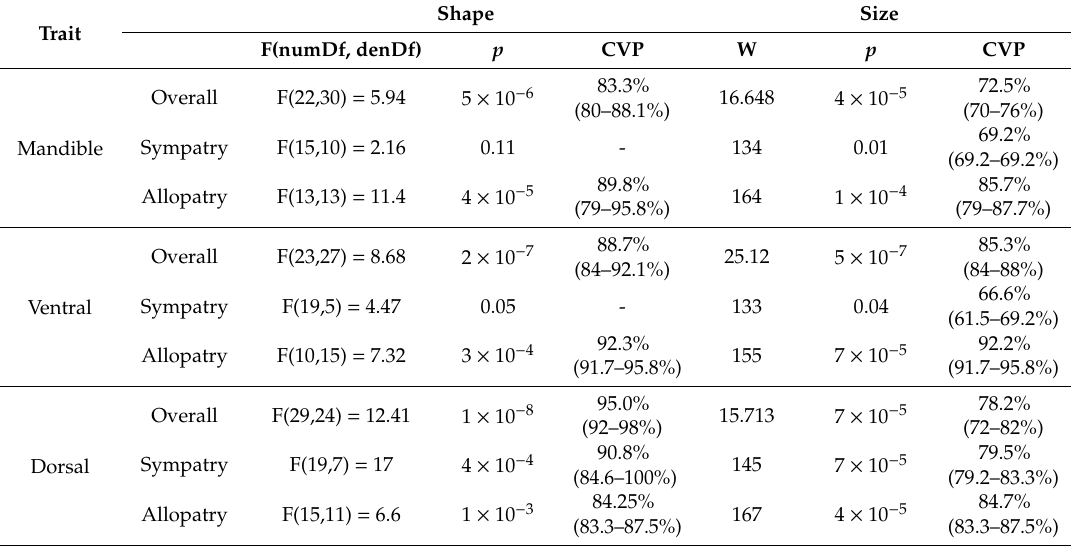
Table 1. Test of di ff erences between species: overall (pooling sympatric and allopatric specimens) and separately sympatric or allopatric populations only. Di ff erences in shape and size were tested using one-way multivariate analysis of variance (MANOVA) and Wilcoxon’s tests, respectively, for ventral and dorsal sides of the cranium and the mandible. P: p -value, numDf and denDf: Numerator and denominator degrees of freedom, W: statistic of the Wilcoxon’s tests. The numerator degree of freedom corresponds to the number of Principal Component (PC) scores included in the analyses. Cross-validation percentages (CVP) are provided as the mean and the 90% confidence interval of the